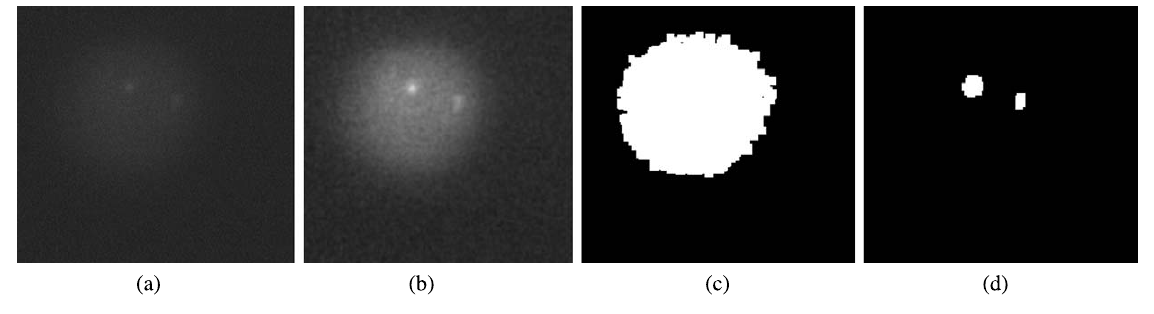
Fig. 7. (a) The ROI containing a potential FISH cell; (b) the pre-processed image through the full-scale contrast stretching and Gaussian filter; (c) the segmented FISH cell by the adjustable threshold algorithm and morphologic processing; (d) The segmented FISH signals by top-hat algorithm and morphologic processing.